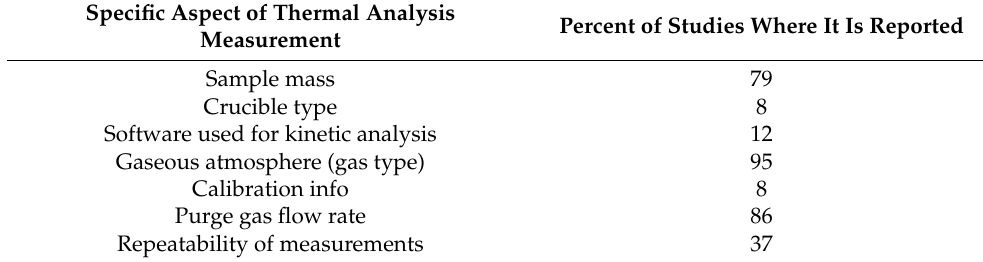
Table 2. Analysis of experimental section of top 100 by citations thermokinetic papers, published in 2021: thermal analysis and kinetic details. Specific Aspect of Thermal